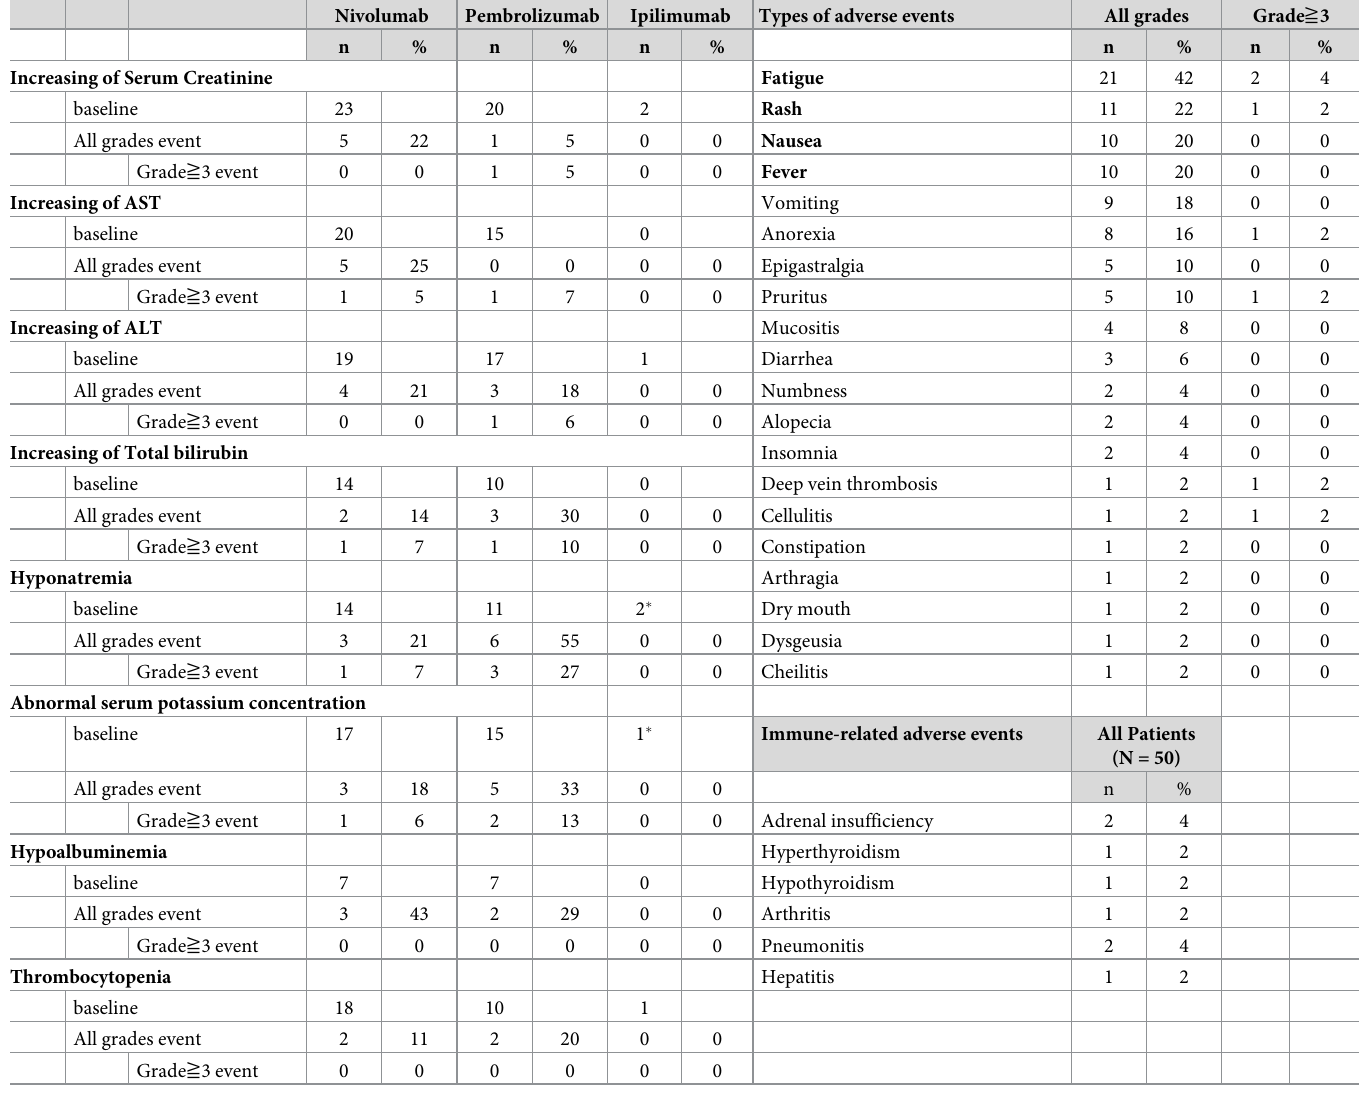
Table 5. Safety of